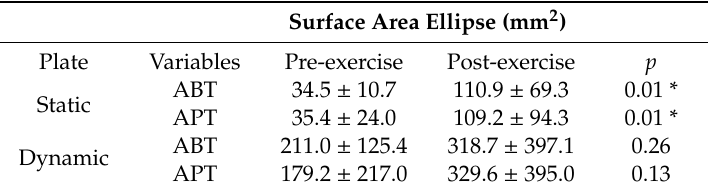
Table 3. Comparison of variations in surface area ellipses on a static and a dynamic plate with eyes open before and after fatigue-inducing exercise.